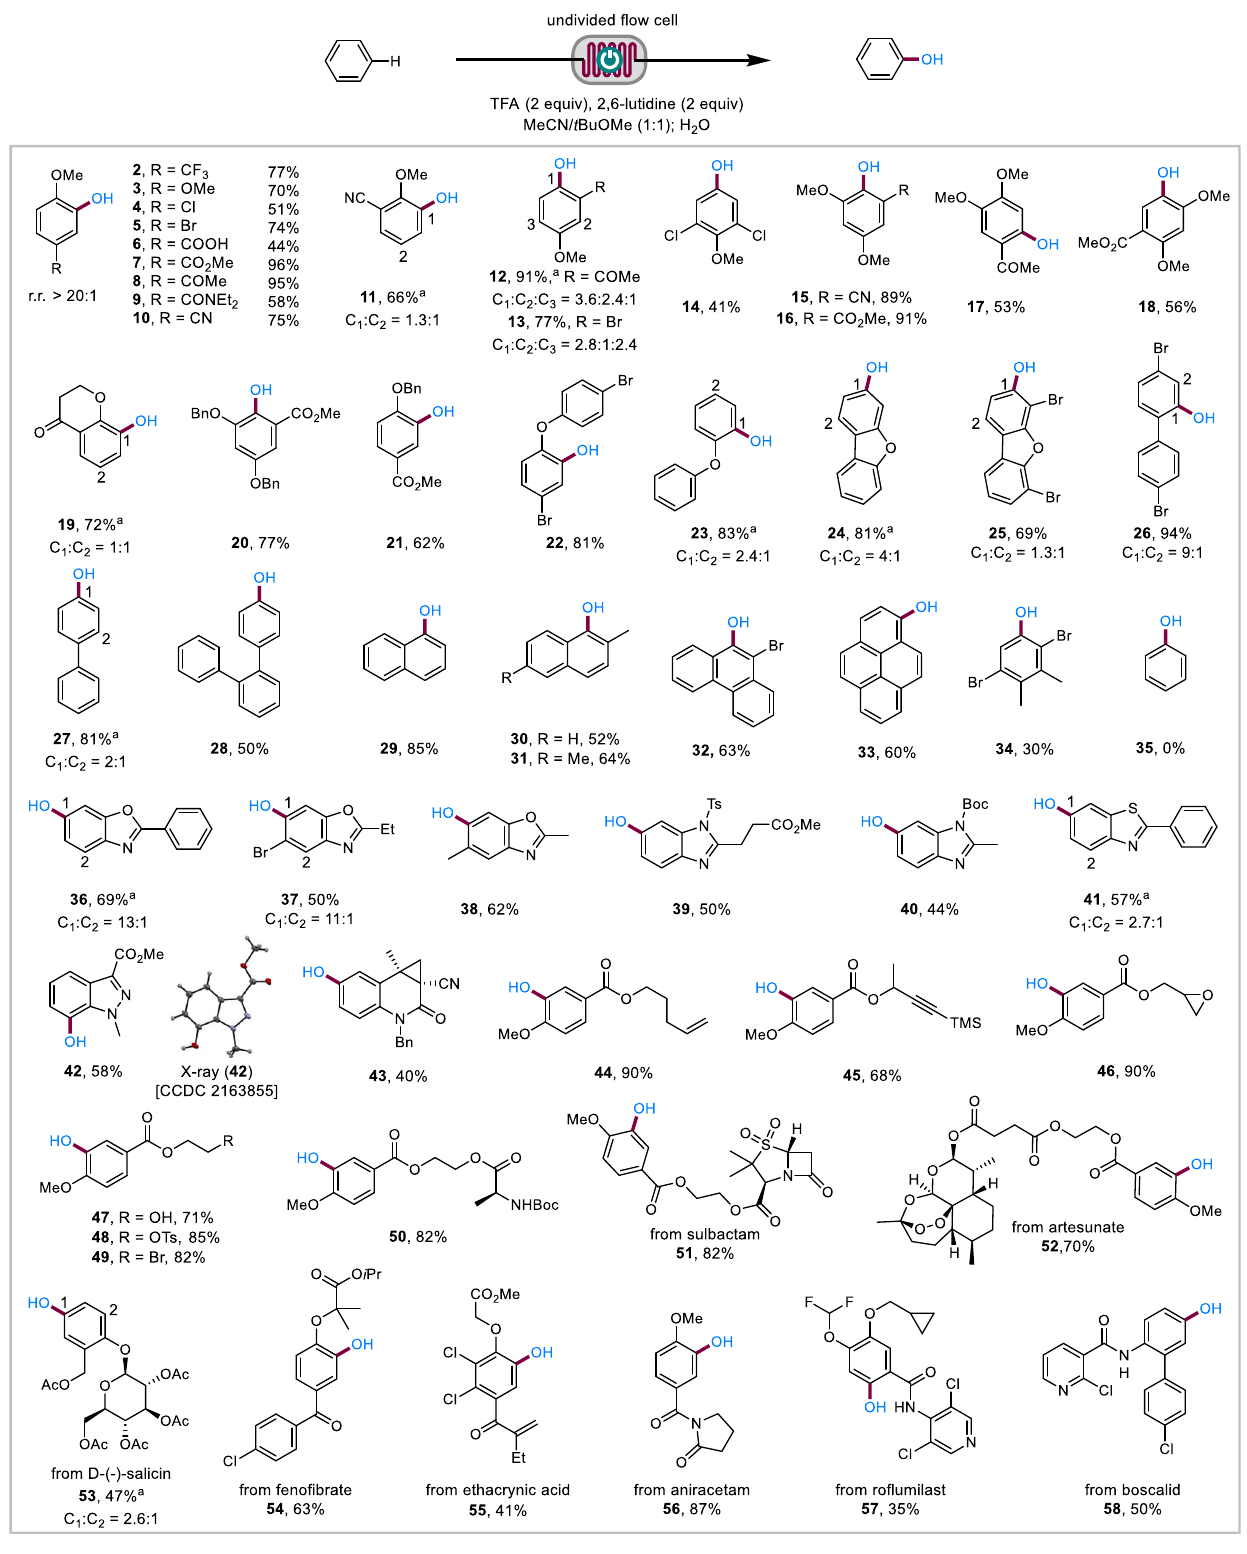
Fig. 2 Reaction scope of electron-rich arenes. Regioisomers were not observed unless otherwise mentioned. Reaction conditions: 0.36 mmol of arene, graphite anode, Pt cathode, 52 – 98 mA, 0.4 mL min − 1 . a Regioisomers separated by fl ash chromatography. Ts tosyl, Boc tert -butyloxycarbonyl, Bn benzyl, Ac